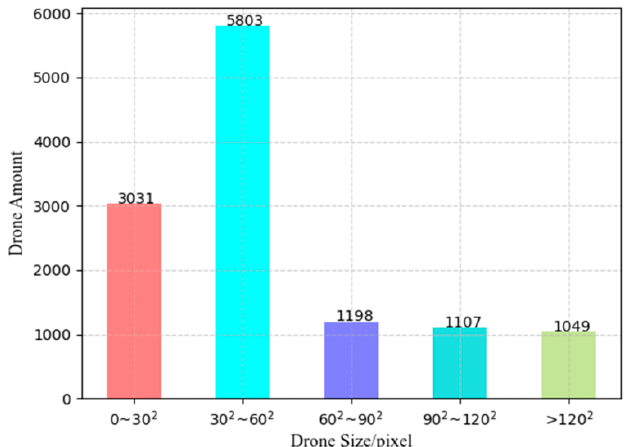
Figure 7. Target size distribution in the high-resolution drone dataset.